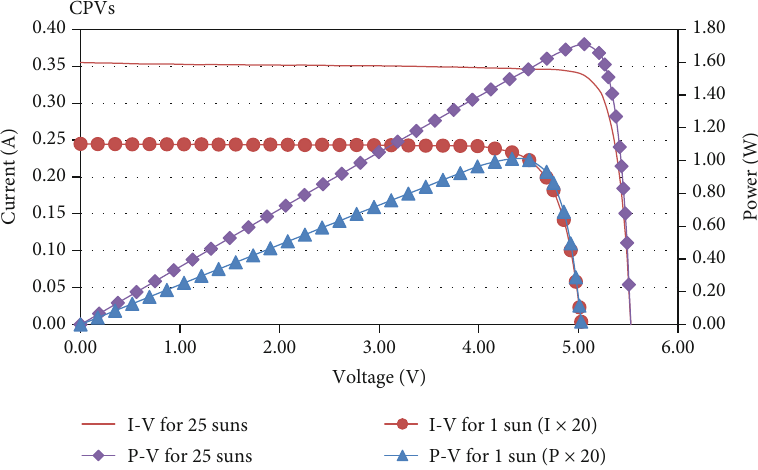
Figure 6: The I-V and P-V characteristics in concentrated and nonconcentrated sunlight for